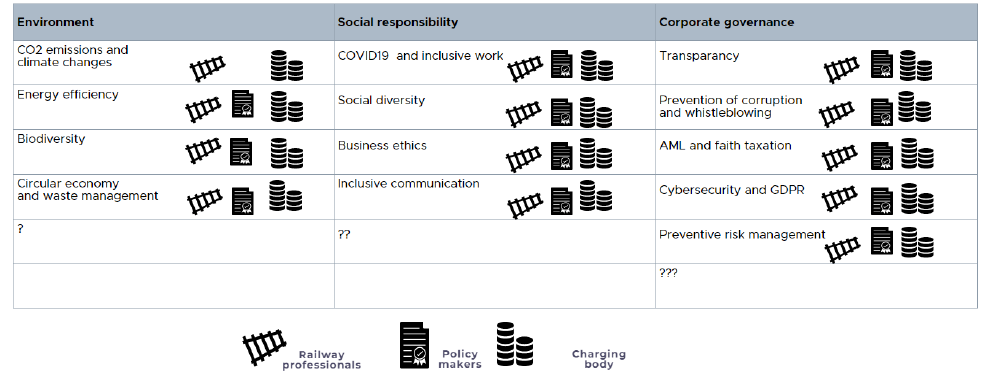
Fig. 2. Involvement of focus group participants in ESG